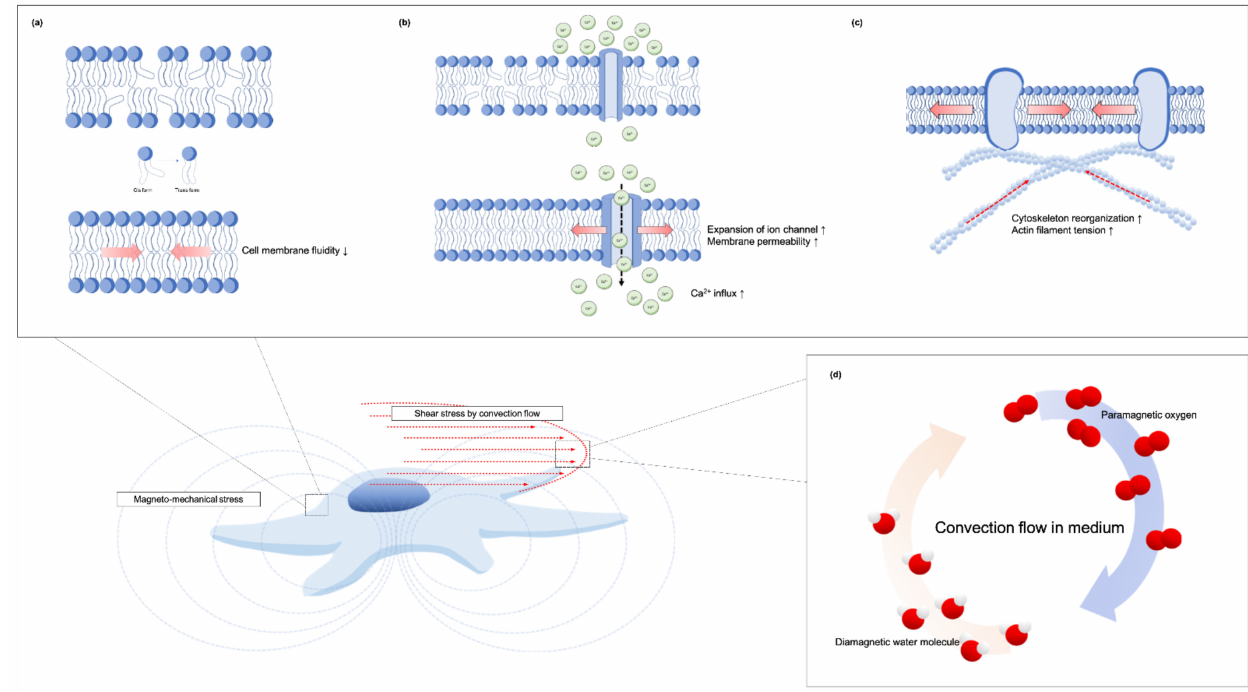
Figure 4. Illustration of SMF-stimulated cells and their putative underlying mechanisms. ( a – c ) Direct magneto-mechanical stimulus to cells causing changes to the cell membrane, ion channels and cytoskeleton; ( a ) Acyl chains in excitable membranes transformed from Cis form to Trans form, thus changing membrane fluidity; ( b ) Expansion of embedded ion channels increasing calcium ions influx; ( c ) Reorganization of the cytoskeleton can regulate signaling transduction and cellular functions. ( d ) Indirect mechanotransduction generated by convection flow in a medium. Different magnetic susceptibility of oxygen and water molecules induces convection flow causing shear stress on